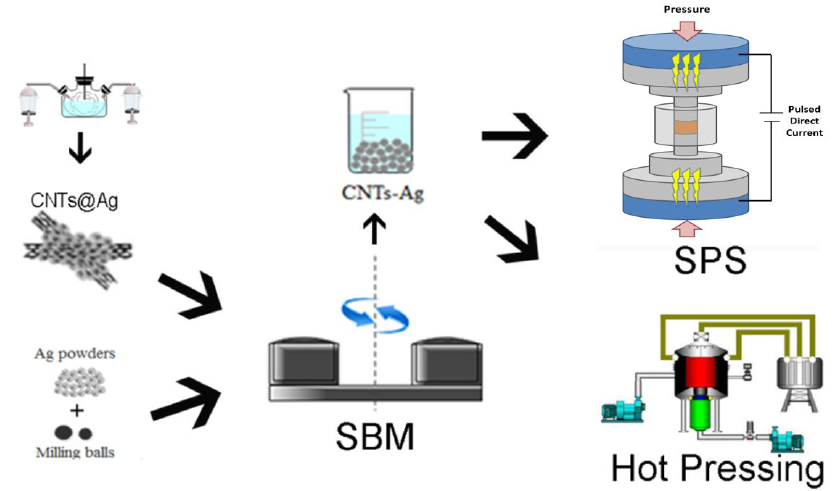
Figure 1. Experimental flow chart for synthesis of CNTs-Ag composites. (SBM: solution ball milling).